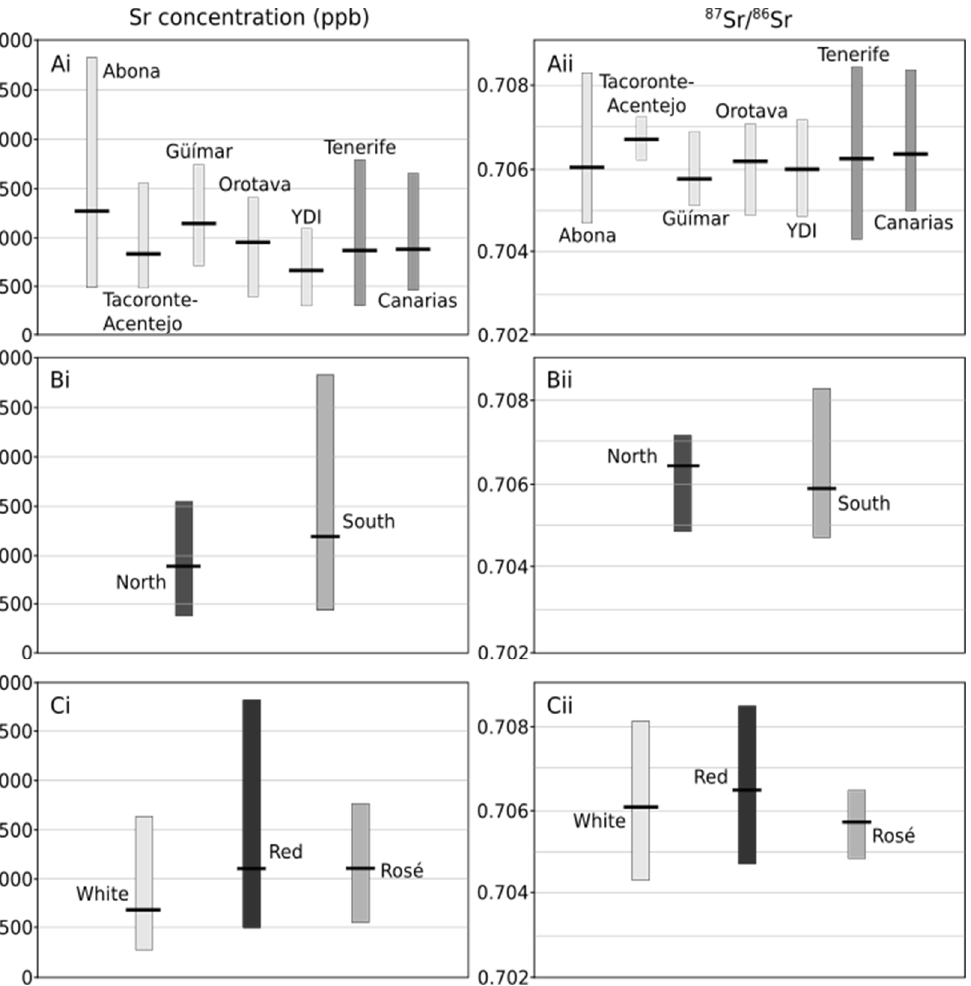
Figure 3. Sr characteristics of Tenerife wines according to ( A ) Denominación de Origen (and the VC label of Canarias, ( B ) north/south region, ( C ) and wine type, with the concentrations ( i ) and isotopic ratio ( ii ) of each category.